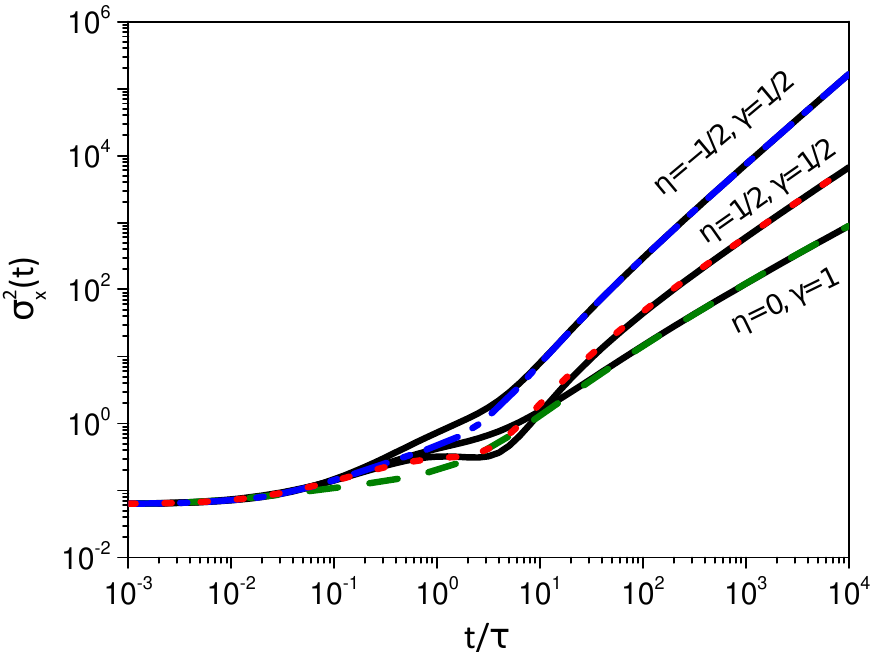
Figure 6. This figure shows the behavior of the mean square displacement for different values of η and γ , for the initial condition ϕ ( x ) = δ ( x − x (cid:48) ) . The colored lines were obtained by considering κ ( t ) = κδ ( t ) and the black lines were obtained for κ ( t ) = ( κ / τ (cid:48) ) e − t / τ (cid:48) . We consider, for simplicity, ¯ κ = 1, τ (cid:48) = τ , x (cid:48) = 1/2, and D τ =